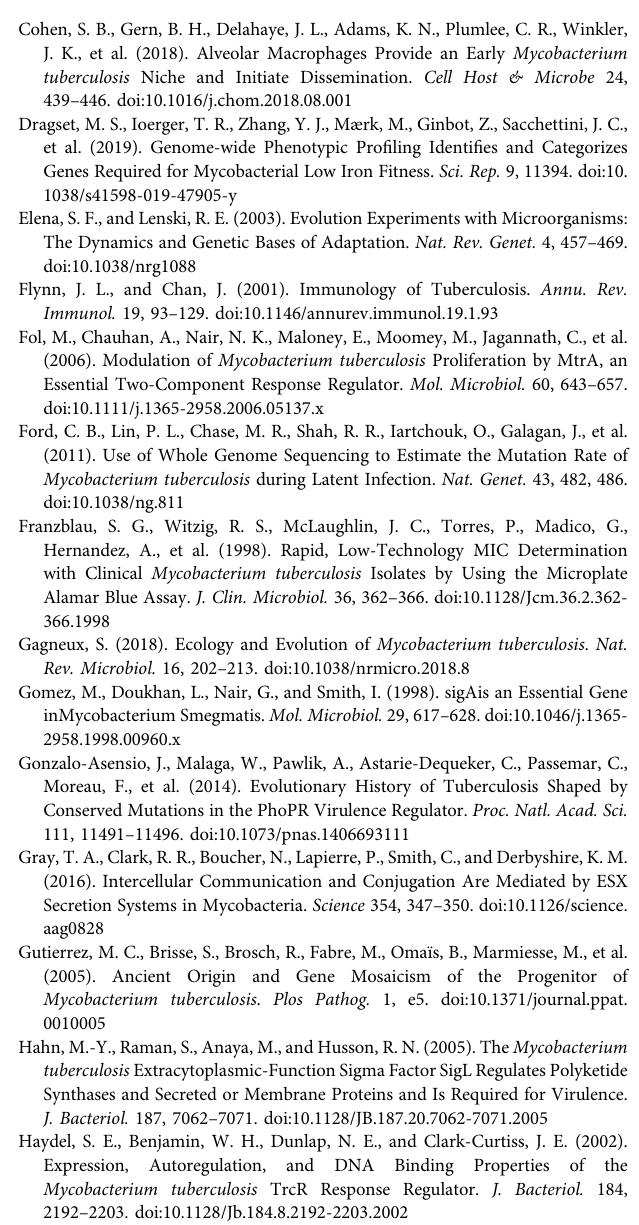
Supplementary Figure S1 | Evolutionary selection of H 2 O 2 -resistant mutations in M. smegmatis Cultures were started from glycerol-frozen stocks and grown to log phase (OD600 of 0.6 - 0.8). Then the cultures were diluted 1:1000 into 5 ml of 7H9 media containing 10% ADS. Hydrogen peroxide (H 2 O 2 ) was then added to a concentration of 0.0293 mM and cultures were grown until the OD600 reached log phase. Cultures were then further diluted 1:1000 and an additional 0.0293 mM of H2O2 was added to the culture. This process was repeated until the H 2 O 2 concentration reached 0.4395 mM. In further rounds of culture, H 2 O 2 was added in steps of 0.0879 mM, instead of 0.0293 mM until an H2O2 concentration of 1.5 mM was reached. To ensure that the H 2 O 2 -resistant phenotype was caused by a chromosomal mutation, selected cultures were sub-cultured for 10 passages and then streaked on plates to obtain single colonies. The distinctive single colonies were then inoculated in liquid culture and actual MIC of H 2 O 2 was